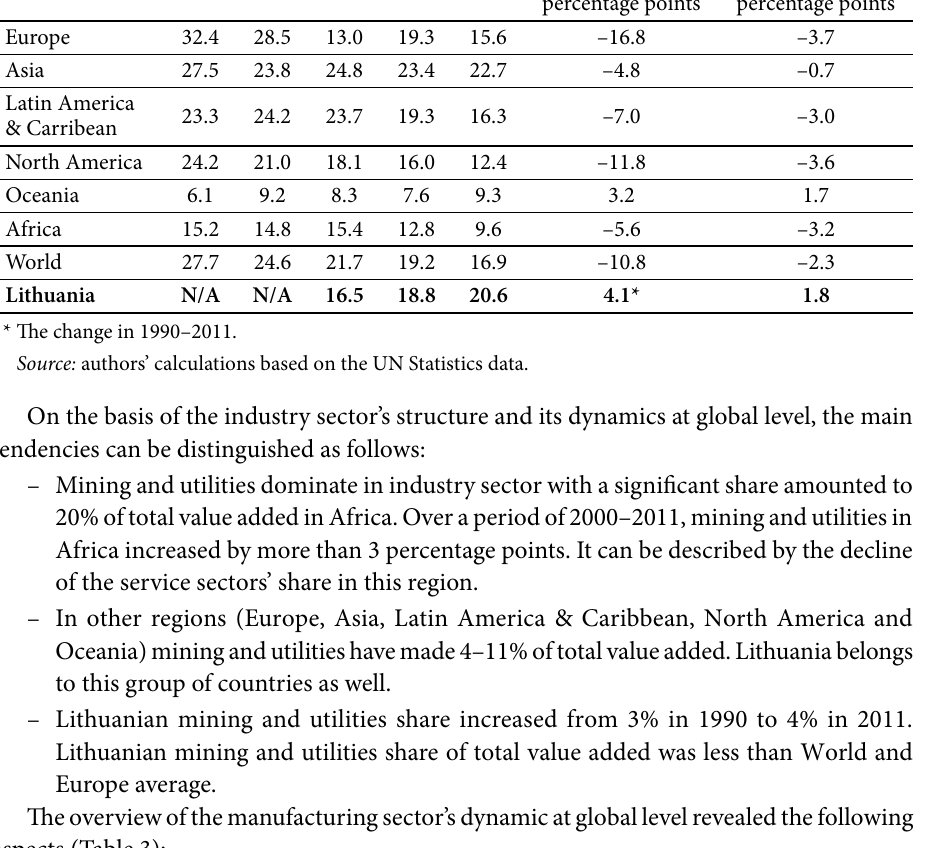
Table 3. Manufacturing share оf tоtal value added, in percent